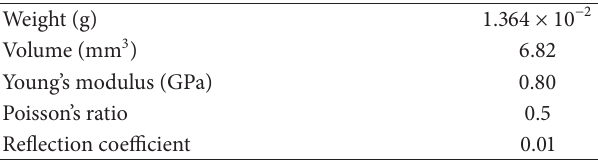
Table 1: Physical parameters for simulation experiment. Weight (g)